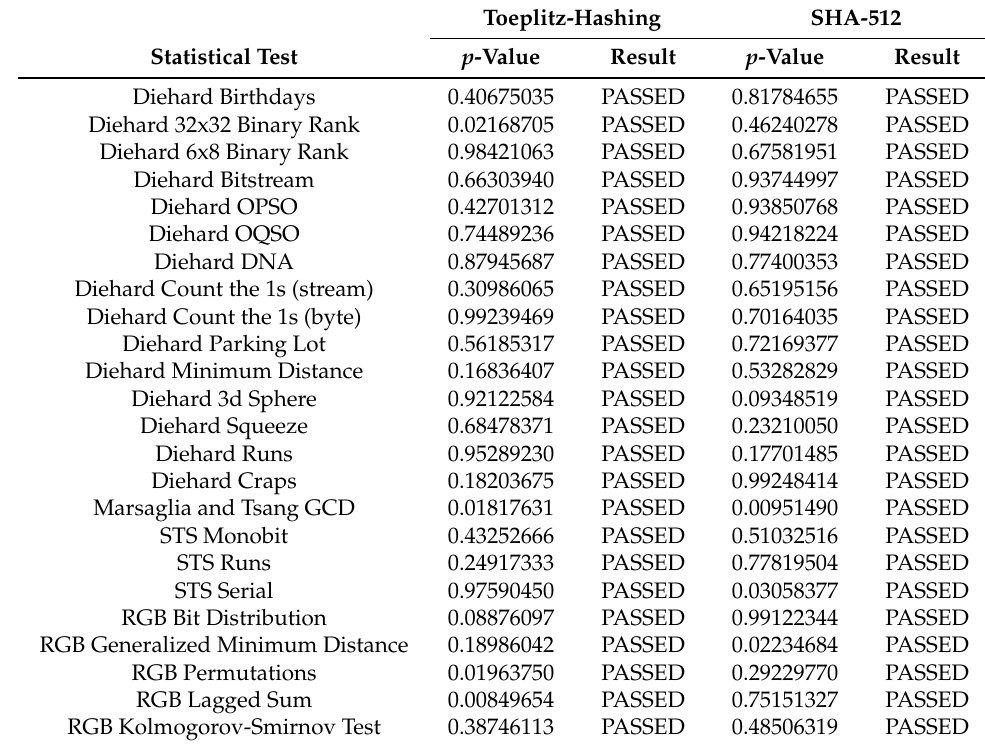
Table A2. Dieharder test suite with the default significance level α = 0.000001. A certain test run is successful if the p -value satisfies 0.000001 ≤ p -value ≤ 0.999999. For tests with multiple variants the worst case is